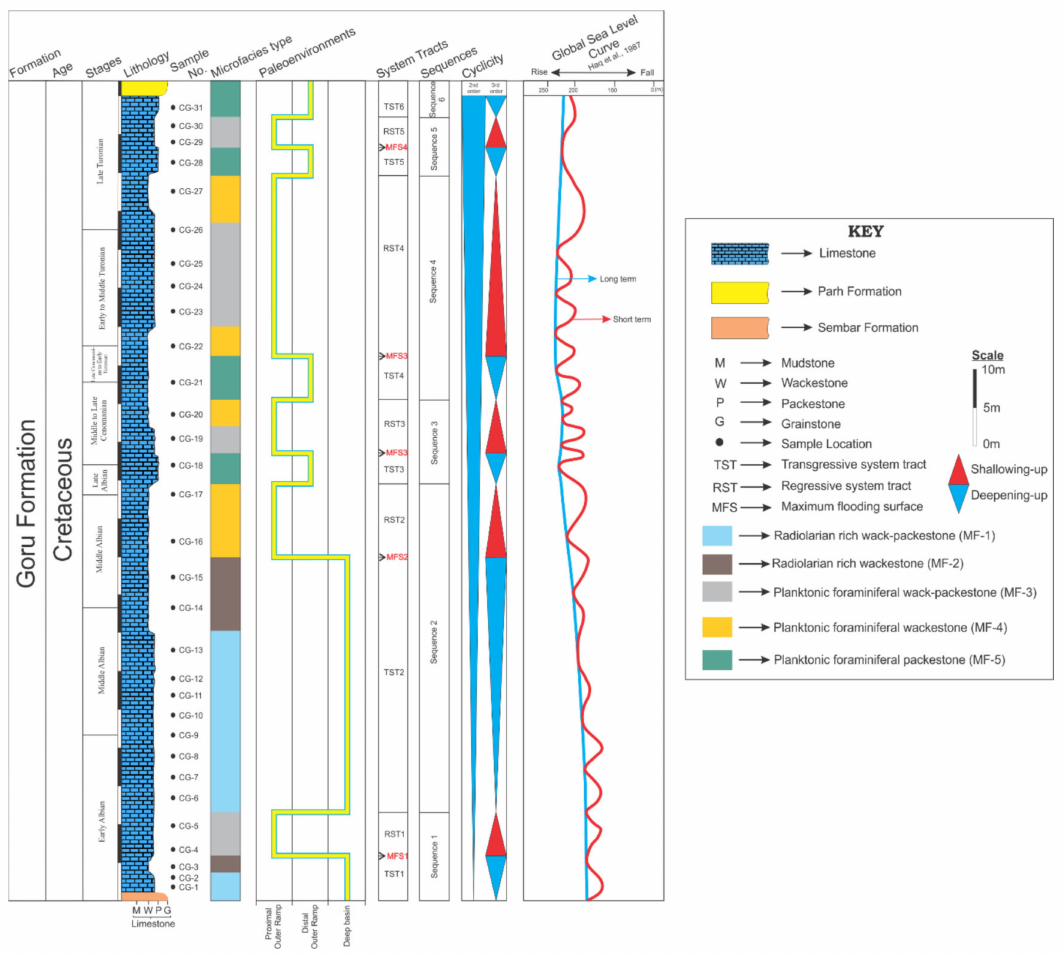
Figure 7. Showing the vertical distribution of microfacies, paleoenvironment, vertical distribution of sequences and system tracts, global sea level curve of the Goru Formation at Chutair Section, Sulaiman Range,